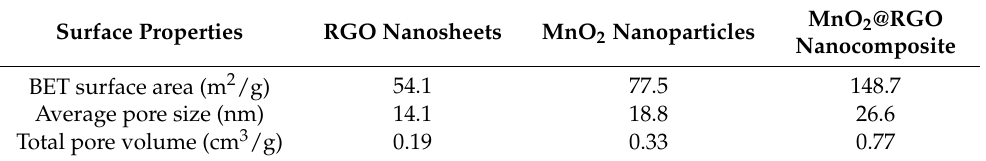
Table 1. BET properties of RGO nanosheets, MnO 2 nanoparticles, and MnO 2 @RGO nanocomposite. Surface